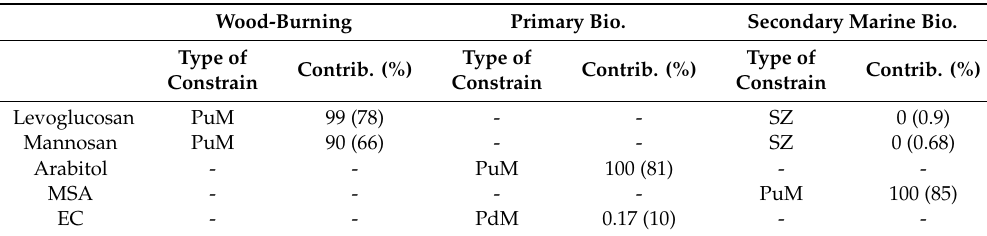
Table 2. List of constraints applied from the base run (PuM: Pull up Maximally; PdM: Pull down Maximally; SZ: Set to 0), and contribution (%) of factor in the constrain solution, compared with the unconstrained run (in